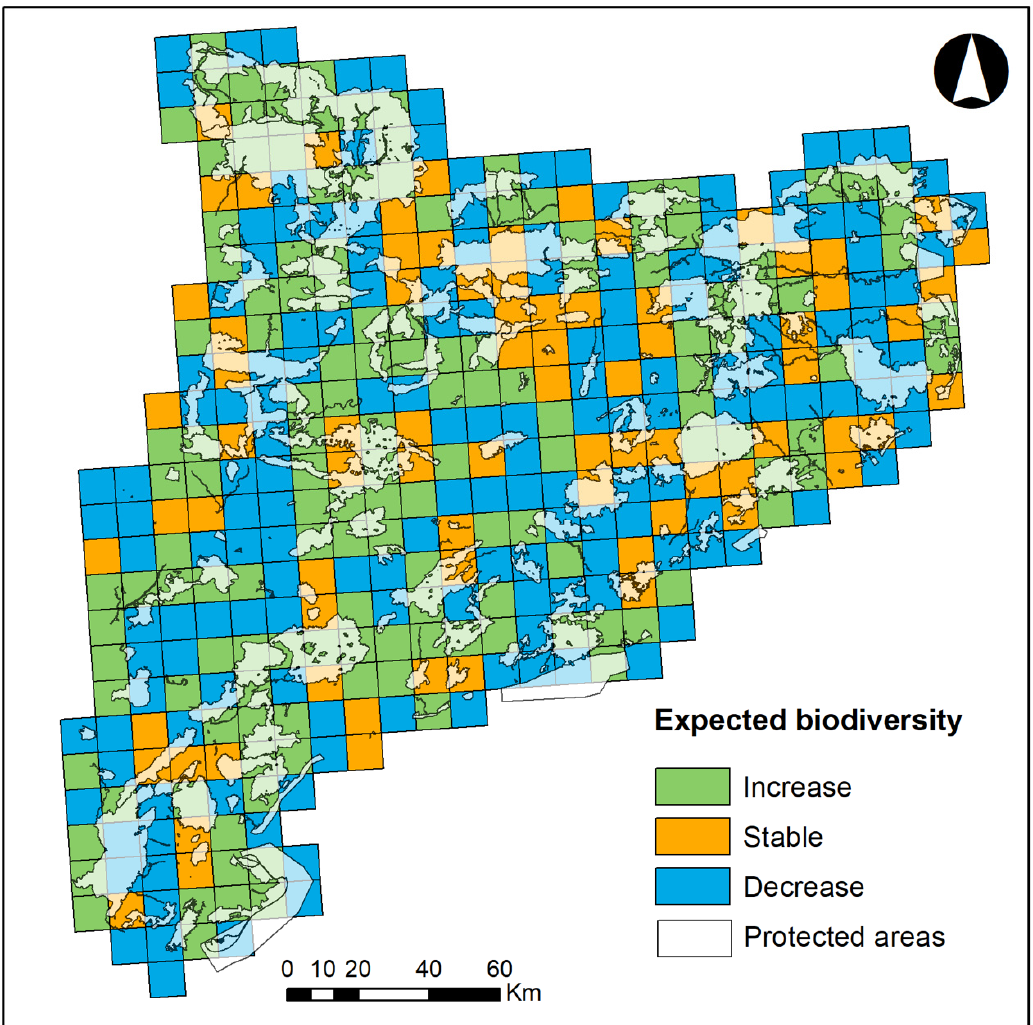
Figure 3. Correspondence between the expected biodiversity and current location of protected areas.